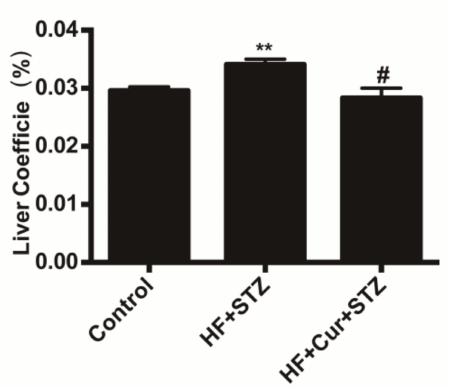
Figure 3. The e ff ect of curcumin intervention on the coe ffi cients of liver tissue to body weight in rats fed a high-fat diet then treated with streptozotocin. The data are expressed as the mean ± SEM. ** p < 0.01, compared with the control group; # p < 0.05, compared with the HF + STZ group. Control ( n = 6), HF + STZ ( n = 10), and HF + Cur + STZ ( n =